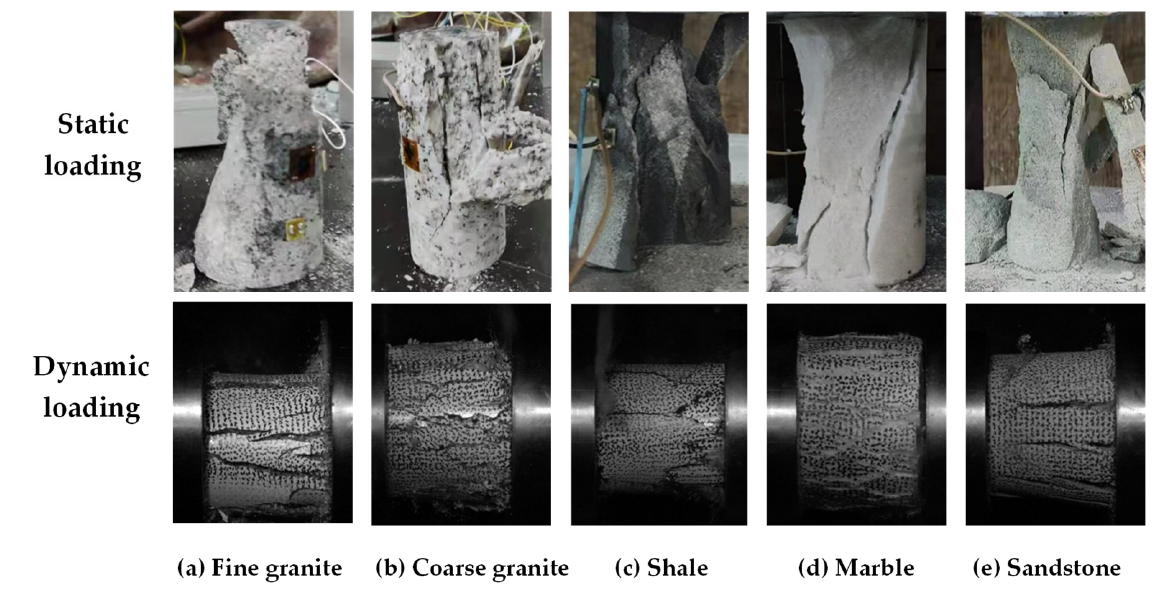
Figure 5. Rock failure under different loading modes.